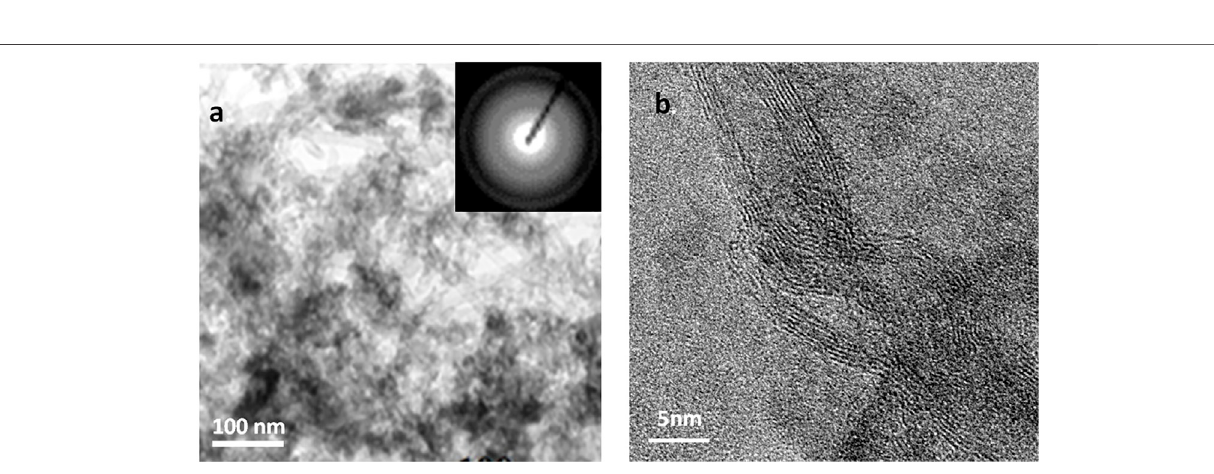
Frontiers in Chemistry |